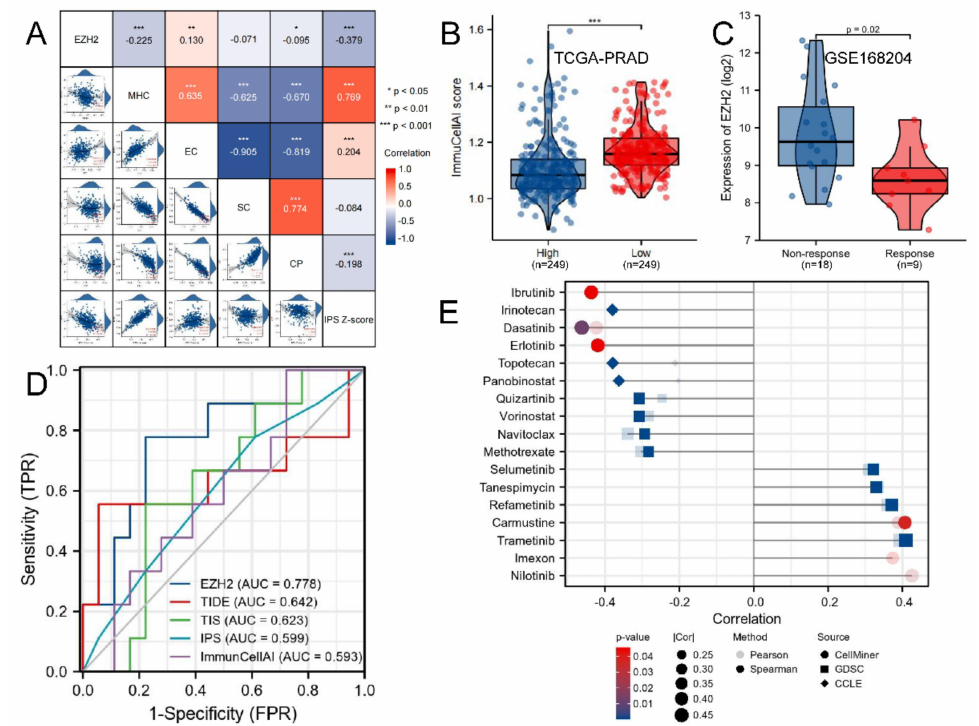
Figure 12. Immunotherapeutic response and drug sensitivity prediction: ( A ) The correlations between EZH2 and MHC, EC, SC, CP, and IPS score in TCGA-PRAD; ( B ) Box-violin plot shows the ImmuCellAI score of EZH2 high- and low-expression groups; ( C ) Box-violin plot shows the distribution of EZH2 for patients with different immunotherapeutic responses in GSE168204 cohort; ( D ) ROC curves of EZH2, TIDE, TIS, IPS, and ImmuCellAI measuring the predictive value about objective response to ICB in GSE168204 cohort; ( E ) Lollipop chart shows the correlation between EZH2 expression and drug sensitivity of tumor cells by RNAactDrug. p -values < 0.05, 0.01, and 0.001 were presented as “*”, “**”, and “***”,